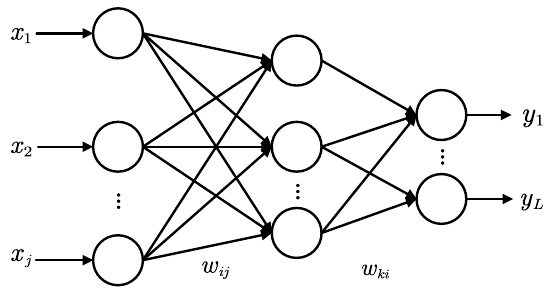
Figure 8. Topological structure of a typical BP neural network.